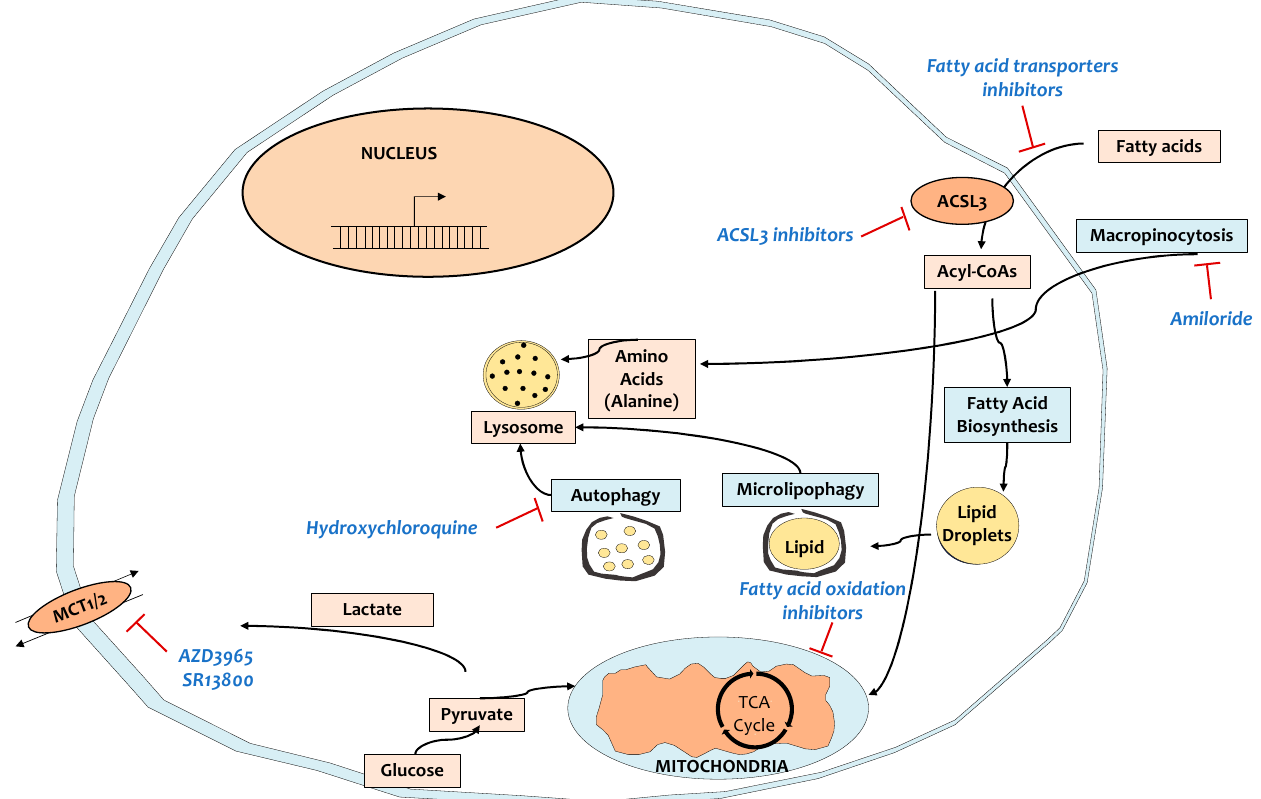
Figure 2. Targeting metabolic reprogramming in patients with PCa. KRAS-mutant tumors rely on metabolic reprogramming, exposing critical vulnerabilities to target for therapy. MCT1/2, monocarboxylate transporters 1/2; ACSL3, acyl-CoA synthetase long-chain 3.